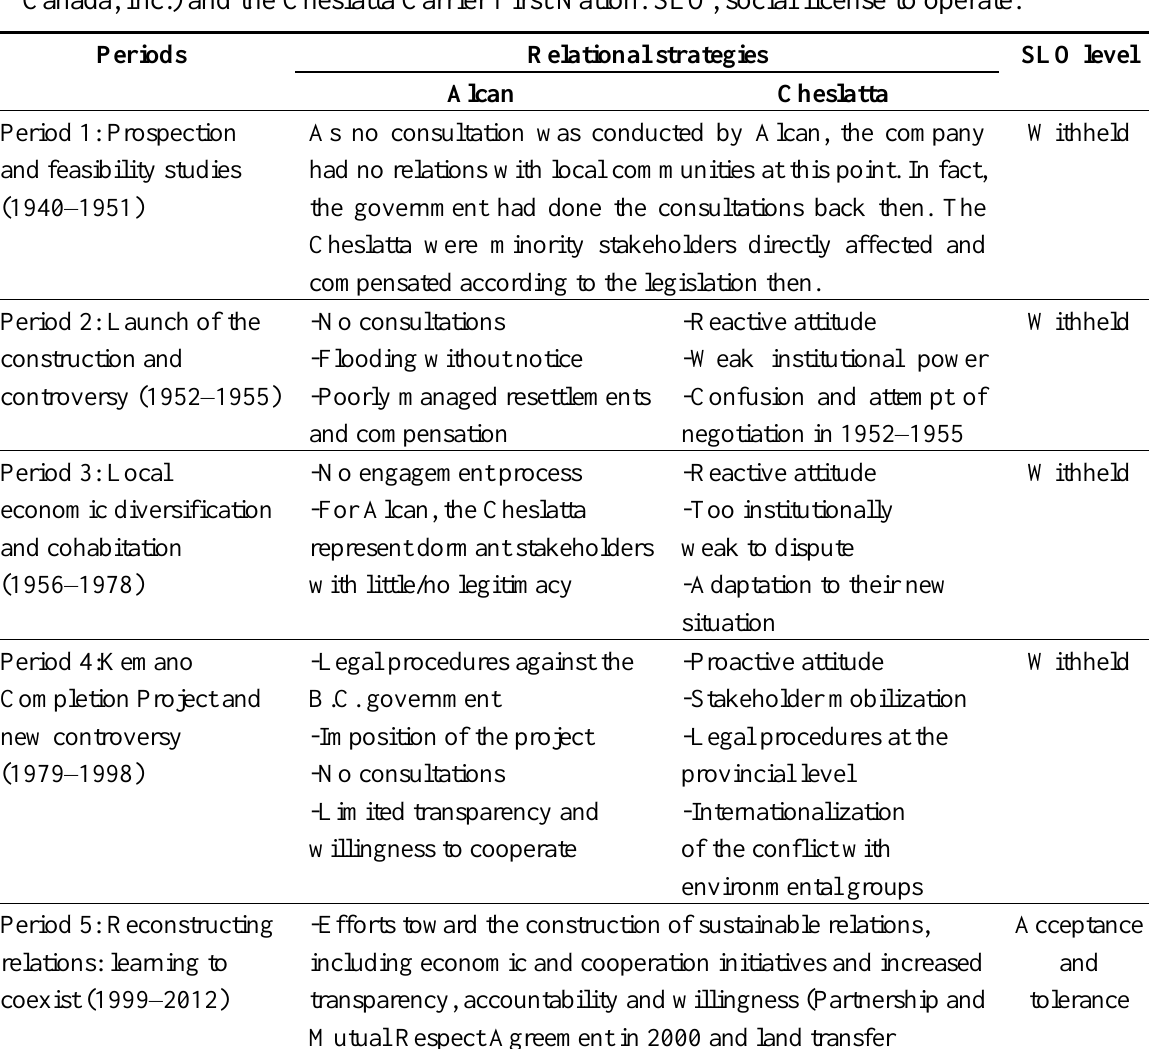
Table 1. Levels of social license to operate in the relations between Alcan (Aluminum